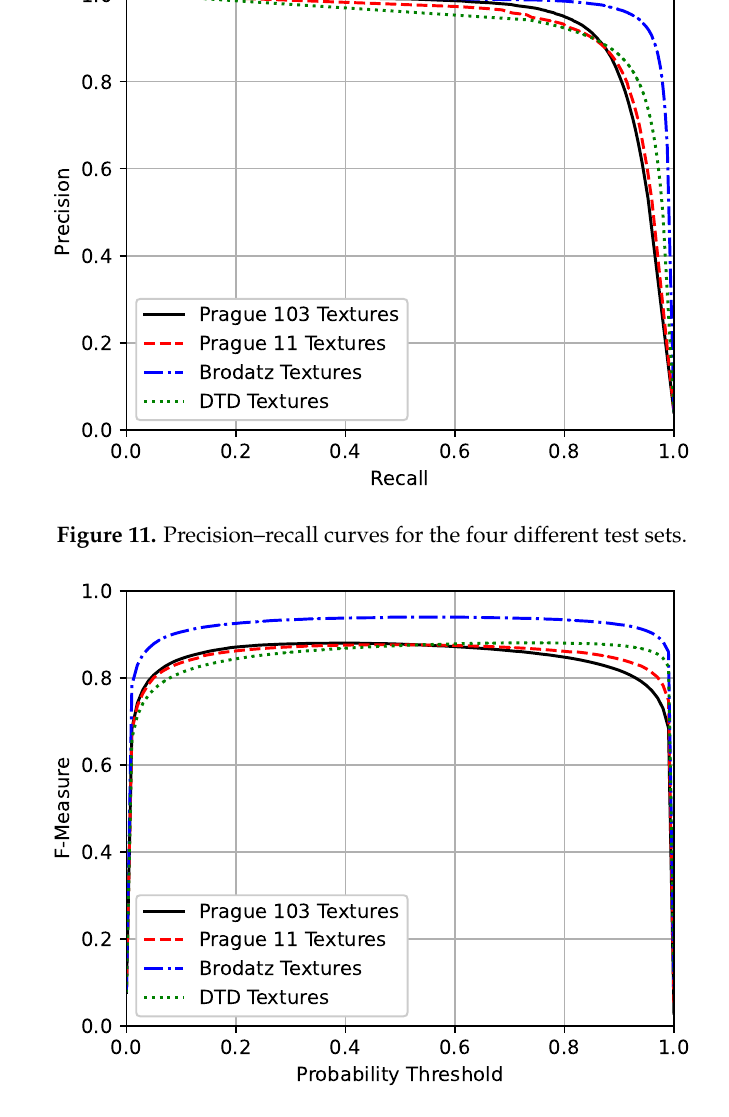
Figure 12. F-measure curves for the four different test